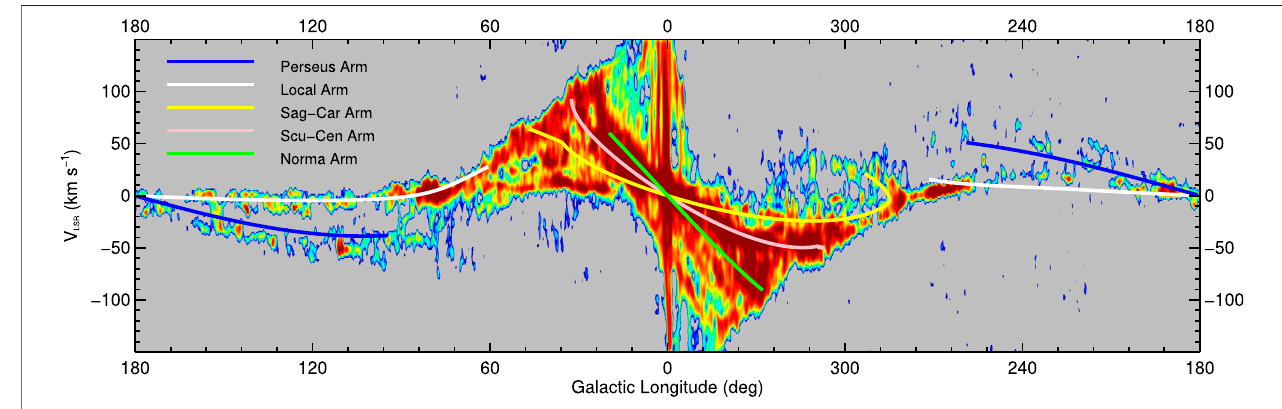
FIGURE4| Thebest fi ttedspiralarmmodelgivebythiswork( Table1 )isoverlaidonthe l − v diagram of 12 CO(1 – 0)ofDameetal.(2001).Thespiralarmsegments are indicated by different colors. To convert the position of spiral arms into the l − v diagram, the fi tted “ universal ” form of the Galaxy rotation curve given by Reid et al. (2019) was adopted. The distance of the Sun to the GC, R 0 is taken as 8.15 kpc. The circular orbital speed at the Sun Θ 0 is 236 km s − 1 (Reid et al.,